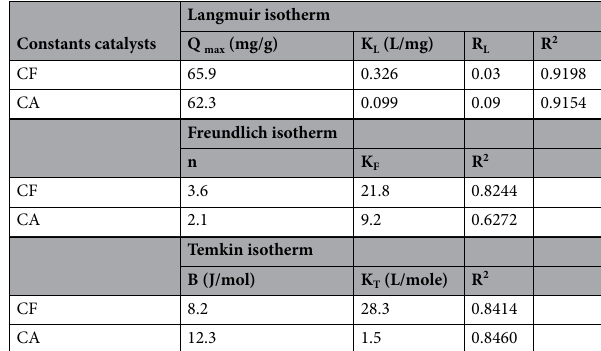
Table 2. Isotherm parameters for disperse red 60 adsorption on CF and